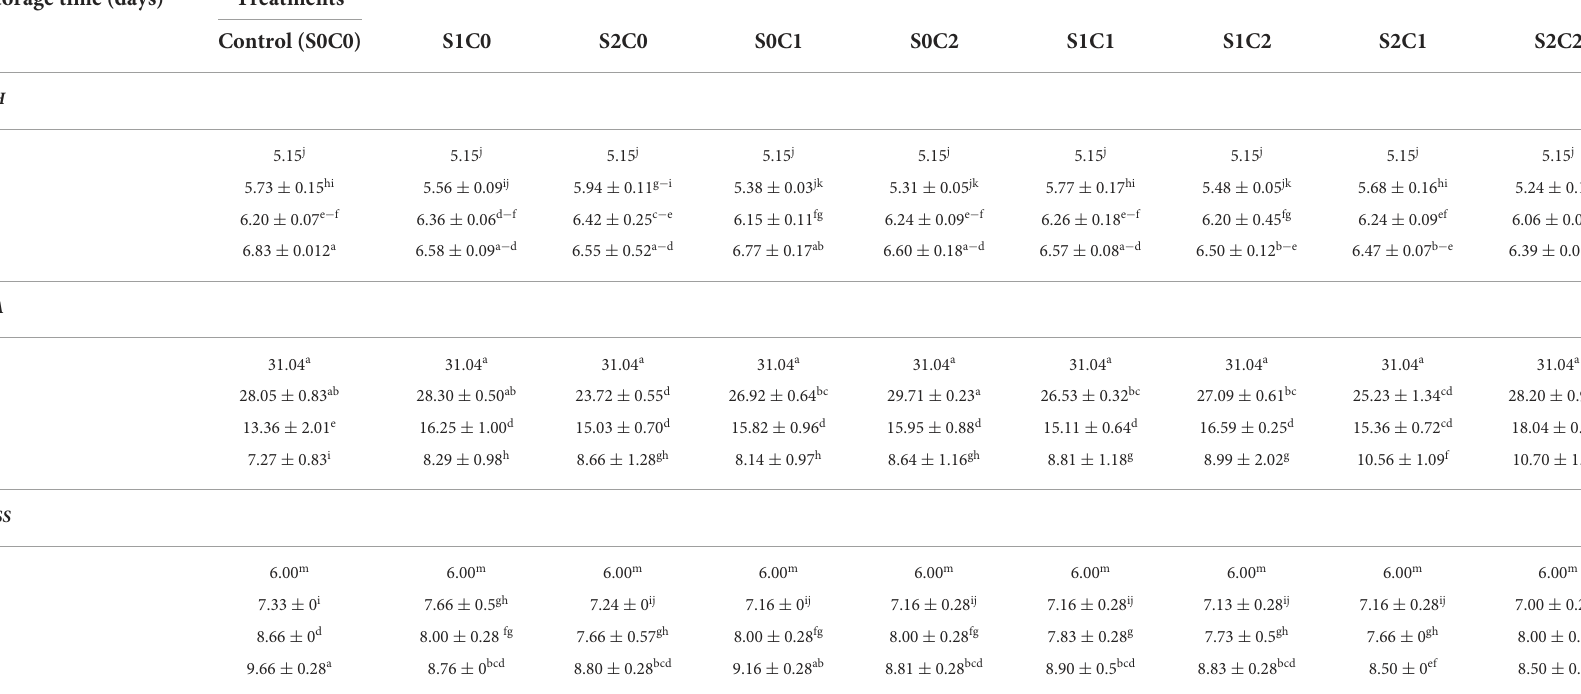
TABLE 1 Effect of pre-harvest foliar spray of SA and caraway oil-coating on pH, titrable acidity (TA) and total soluble solids (TSS) of pepper fruits during cold storage period. Storage time (days)